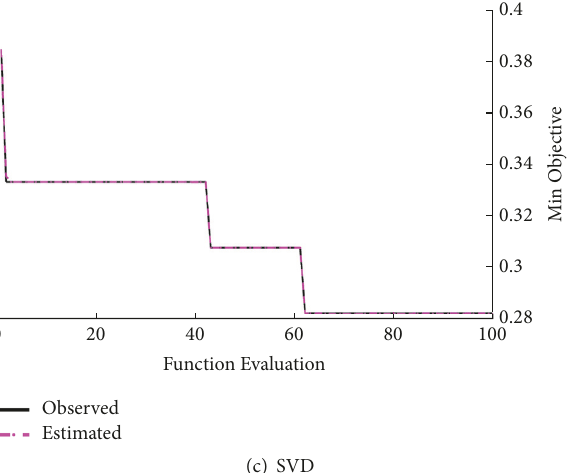
Figure 18: Convergence rates of the optimized Naive-Bayes classifier for ICA, PCA, and SVD data reduction techniques.